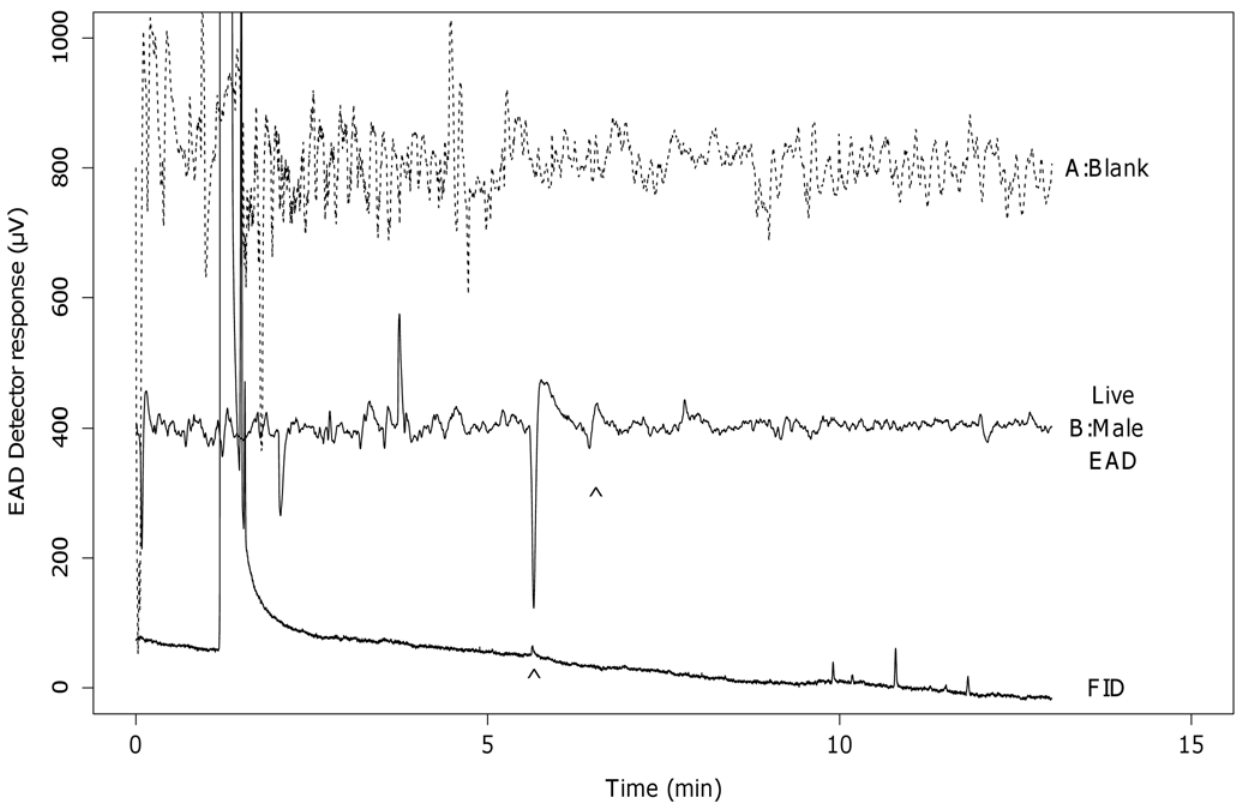
Fig 2. GC-EAD response of male antennae to one of the glass wool extracts of the female headspace. The arrow indicates the peak of interest in the FID signal and the presence of a smaller second response. A: The response to the blank. B: The averaged response of four different sample recordings. (EAD response at 5.61 min: 590 ± 50.33 μ V, mean ± SE, N =